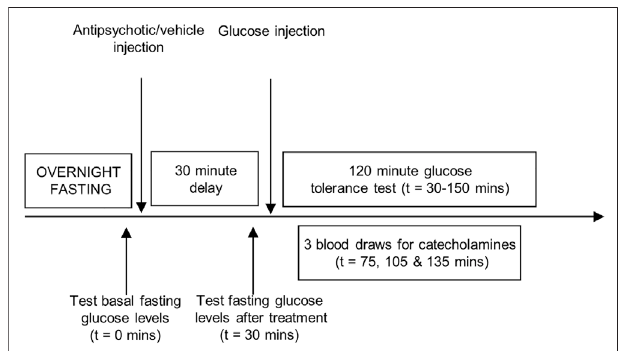
FIGURE 1 | Experimental procedures. Representation of the sequence of events during the intraperitoneal glucose tolerance test. Adult, female Sprague-Dawley rats were fasted overnight. A baseline fasting blood glucose measurement was taken ( t = 0 min), immediately followed by treatment with one of the four antipsychotic drugs or vehicle. Glucose levels were measured30 minlater( t =30 min),followedbytheglucosechallenge(1 g/kg/ ml, i.p.) with repeated sampling of blood glucose readings every 15 min for 2 hours ( t = 30 – 150 min). Three larger blood draws were performed at t = 75, 105 and 135 min to measure peripheral catecholamine